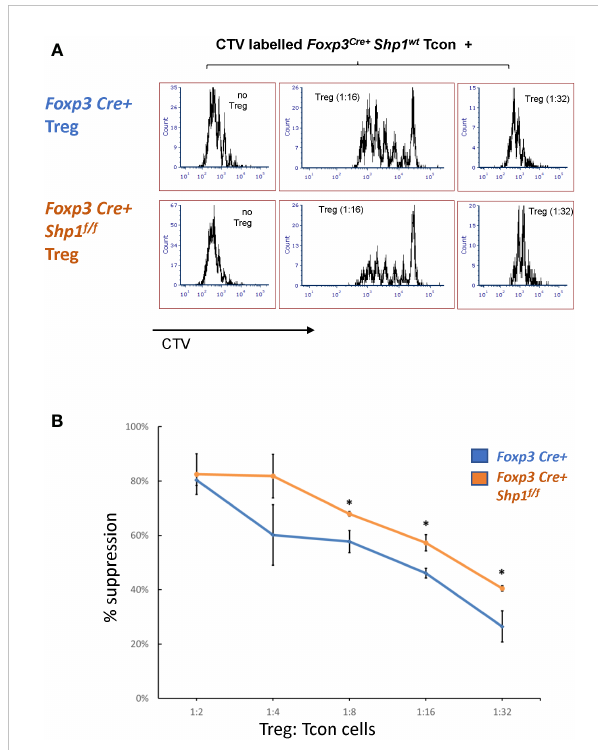
FIGURE 6 SHP-1-de fi cient Treg cells display increased suppressive activity in vitro . (A , B) Treg (CD4+CD25+ isolated from Foxp3 Cre+ Shp-1 f /f mutant or Foxp3 Cre+ control mice) and CTV-labeled Tcon (CD4 +CD25- from control mice) cells were co-cultured at the indicated ratios. (A) Histogram depicts CTV-dilution of Tcon cells as a measurement of proliferation. Data are representative of 3 independent experiments with each n= 1 - 3 mice (6-9 weeks) per genotype. (B) Suppression capacity of Treg cells based on data obtained in (A) Error bar represents SD. *, p ≤